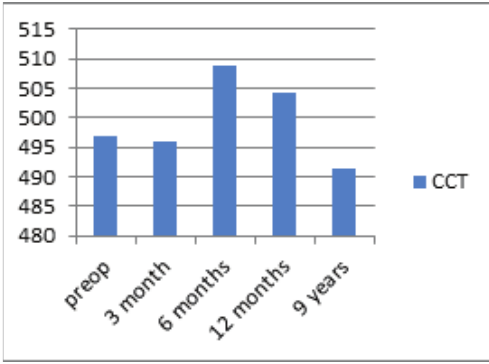
Figure 3. Changes in CCT (µm).